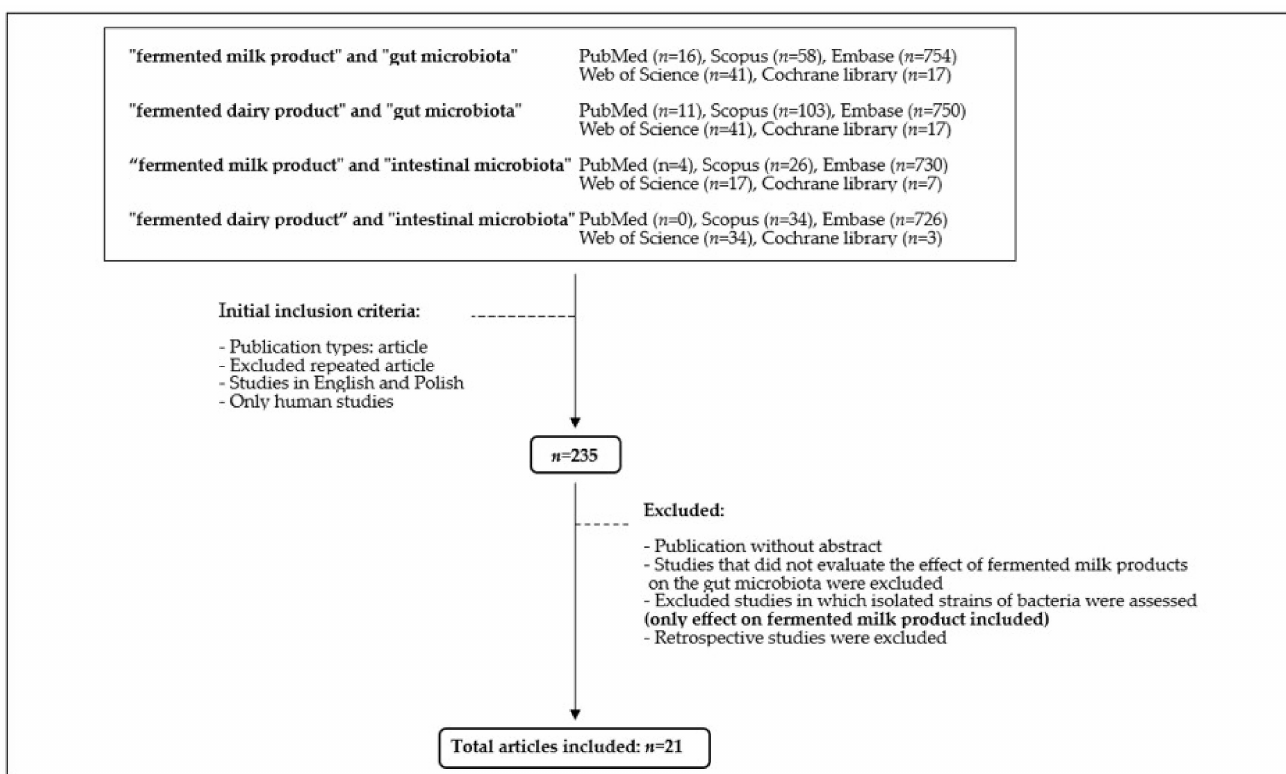
Figure 1. Search